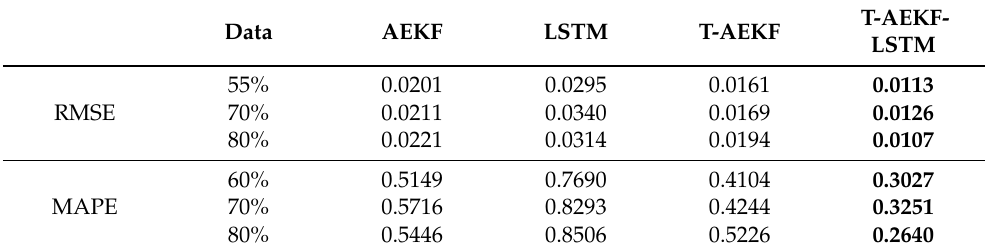
Table 4. The prognostic results for FC2.